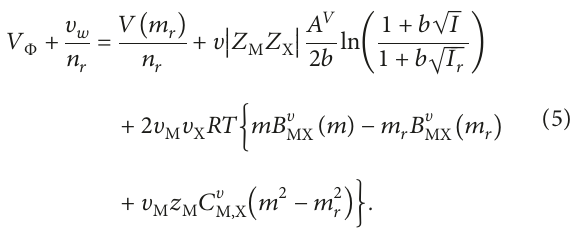
Table 4, with the correlation coefficients ( R 2 ) and standard deviations of 0.9997 and 0.00007, respectively.